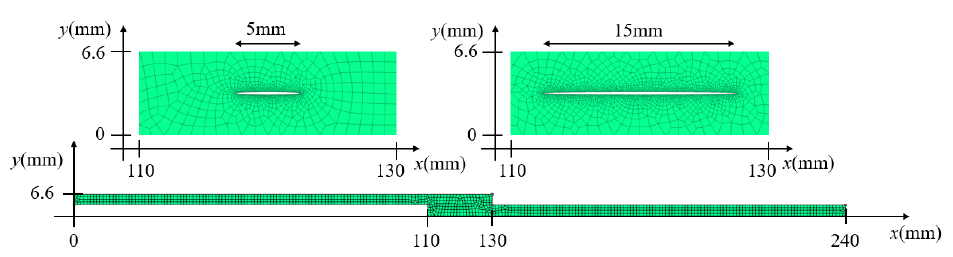
Figure 5. Dimensions of the SLJ.